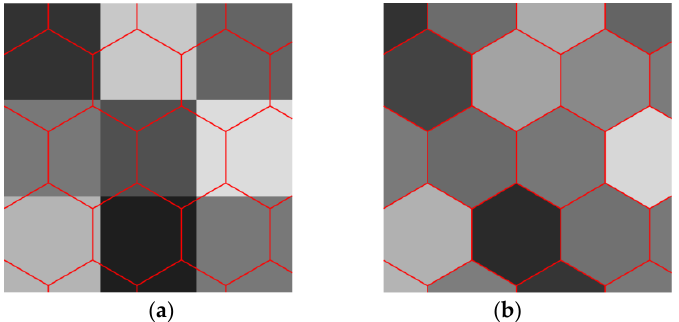
Figure 4. The procedure from square pixels to hexagonal pixels by half-pixel shifting method.